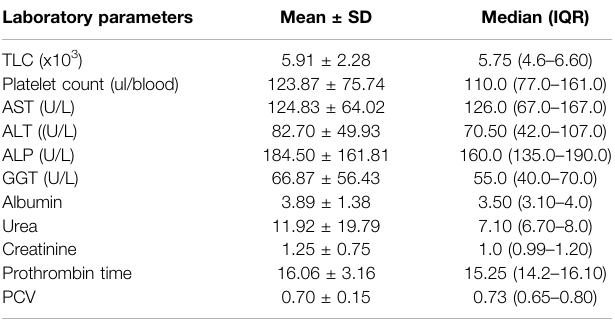
TABLE 2 | Descriptive analysis of the studied cases according to different laboratory parameters for the HCC group ( n = 90). Laboratory parameters